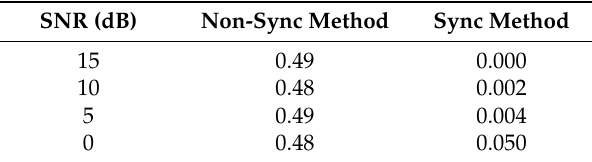
Table 1. Uncoded bit error rate in the simulation.